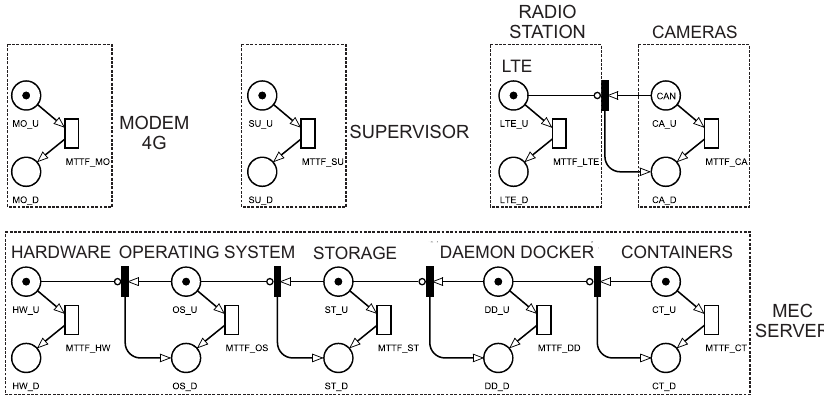
Figure 2. Stochastic Petri net (SPN) model to assess the reliability of a smart city surveillance architecture.